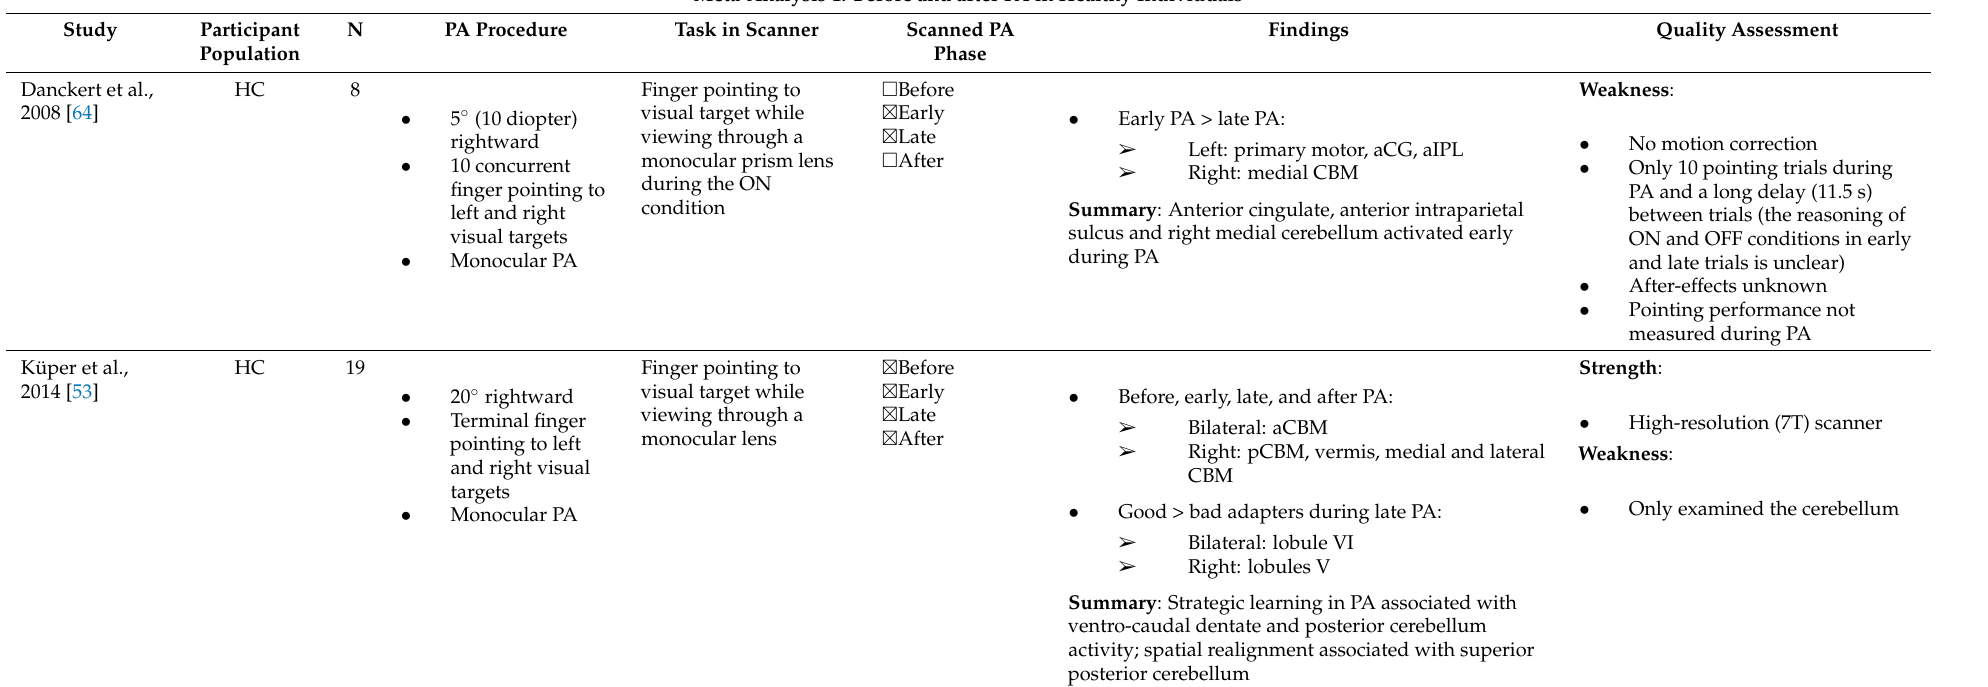
Meta-Analysis 1: Before and after PA in Healthy